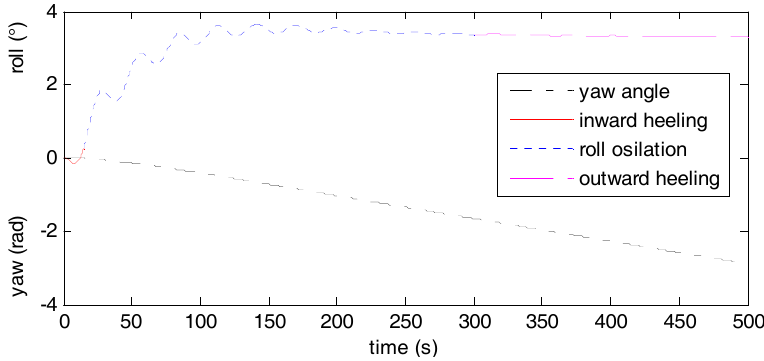
Figure 2. Ship’s course and roll response to rudder motion of port 5°.